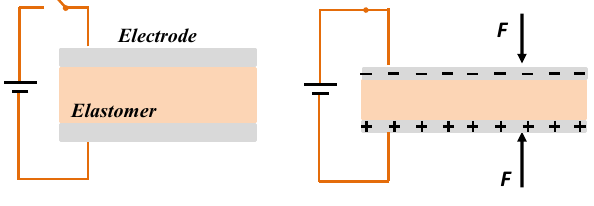
Figure 1: Actuation mechanism of DE